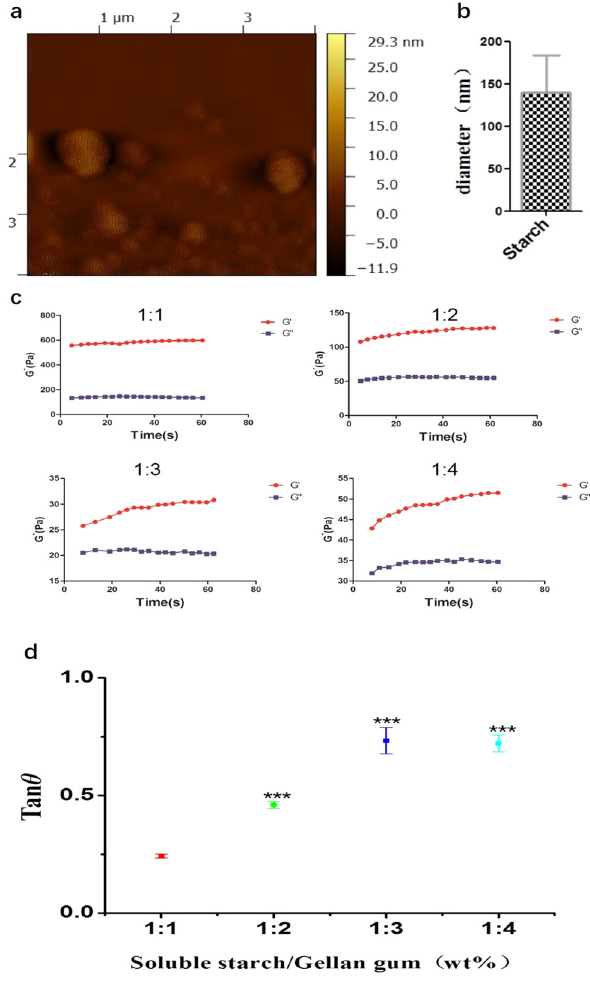
Figure 2: AFM of starch granules and rheological properties of GG/ST sca ff olds with di ff erent ratios. ( a ) AFM; ( b ) starch particle size; ( c ) G ′ and G ″ in amplitude mode; ( d ) loss angle. *** p < 0.001 by one - way ANOVA